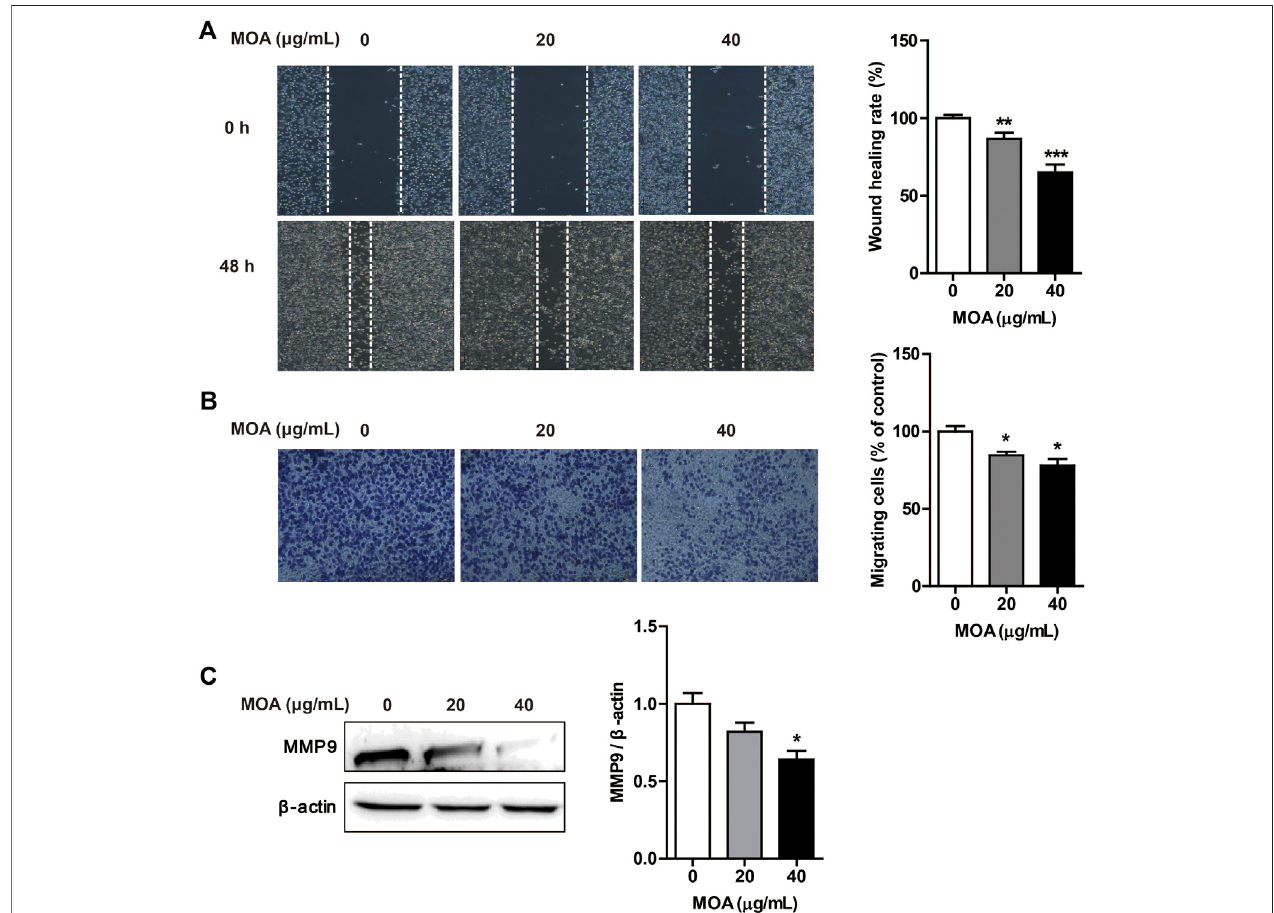
FIGURE 3 | Treatment with MOA inhibited PC3 cell migration. PC3 cells were treated with MOA (0, 20, and 40 μ g/ml) for 48 h, and cell migration was assessed using the wound healing assay (A) and transwell assay (B) . (C) The migration protein MMP9 was detected by western blotting, with β -actin as a loading control. Results are expressed as the mean ± SEM of three independent experiments. * p < 0.05, ** p < 0.01, and *** p < 0.001 vs. 0 μ g/ml.